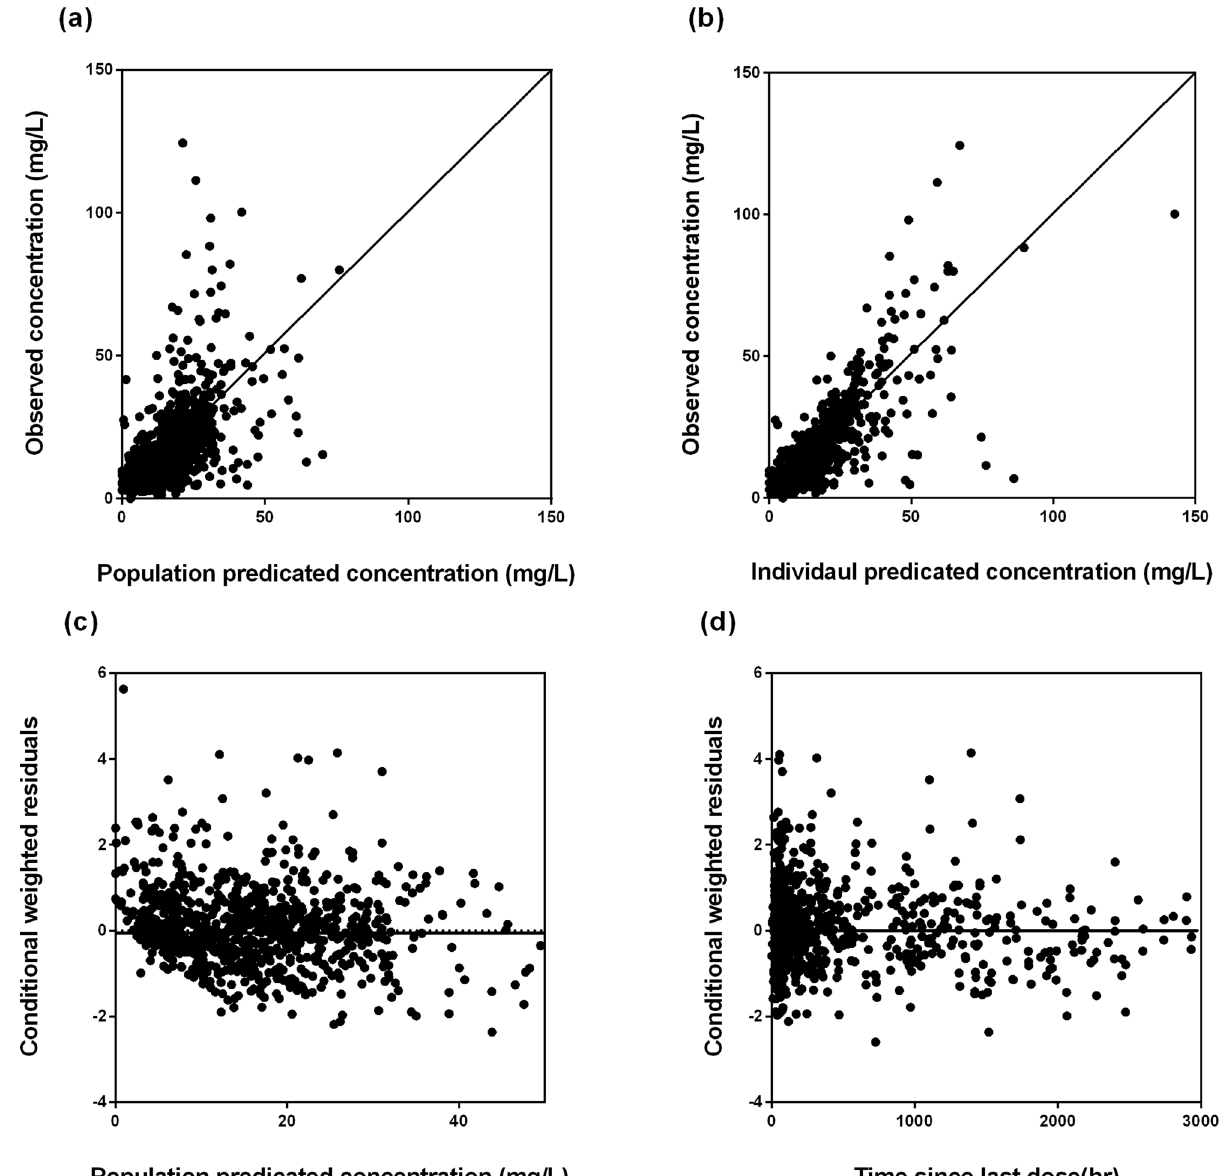
Figure 1. Goodness-of-fit plots of the final population pharmacokinetics (PK) model for vancomycin. Observed vancomycin concentrations vs . (a) population-predicted concentrations and (b) individual-predicted concentrations. Conditional weighted residuals vs. (c) population-predicted concentrations, and (d) time since last